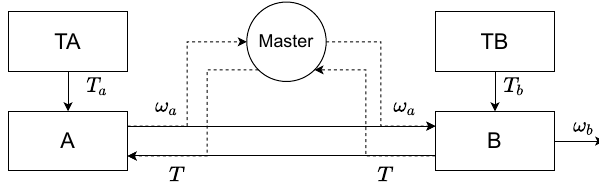
Figure 8. Co-simulation example of